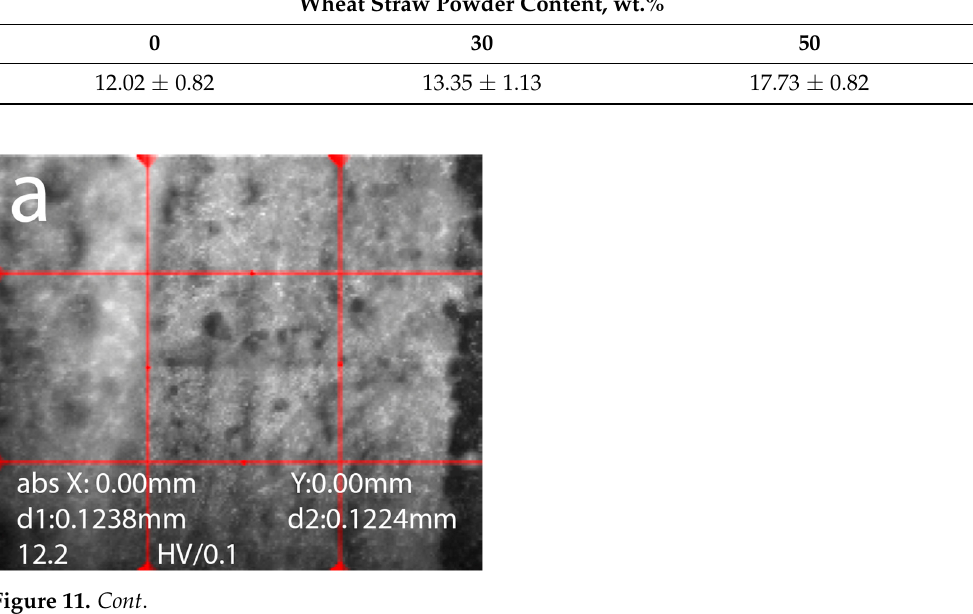
Figure 11 . Image of the imprint of microhardness tester indentor when measuring microhardness at a load of 100 g on the surface of polymeric binder ( a ) and composites with wheat straw with the fi ller content: ( b )—30 wt.%; ( c )—50 wt.% . The analysis of the obtained data on the microhardness of composites with wheat straw (Table 5) showed that the introduction of wheat straw leads to an increase in micro- hardness of the composite surface. 3.5. Behavior of Composites in an Aggressive Environment